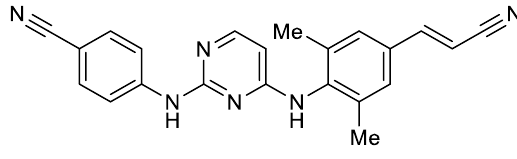
Figure 4. Structure of rilpivirine.